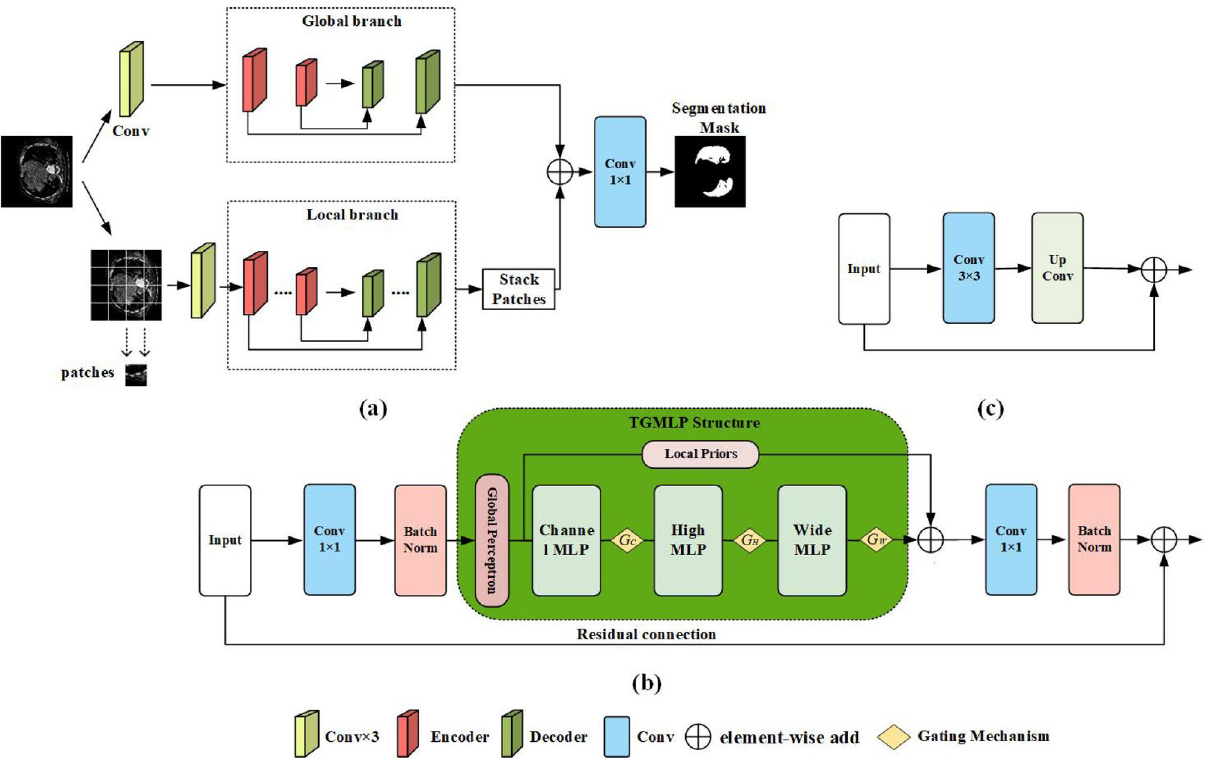
Figure 2. ( a ) shows the main architecture of the TGMLP U-Net with local-global training strategy. ( b ) Indicates that Encoder in TGMLP U-Net uses TGMLP and Convolution. ( c ) indicates that Decoder in TGMLP U-Net uses 3 × 3 Convolution layer, Deconvolution and jump connection (the Layer Norm and residual connection are omitted in Fig.